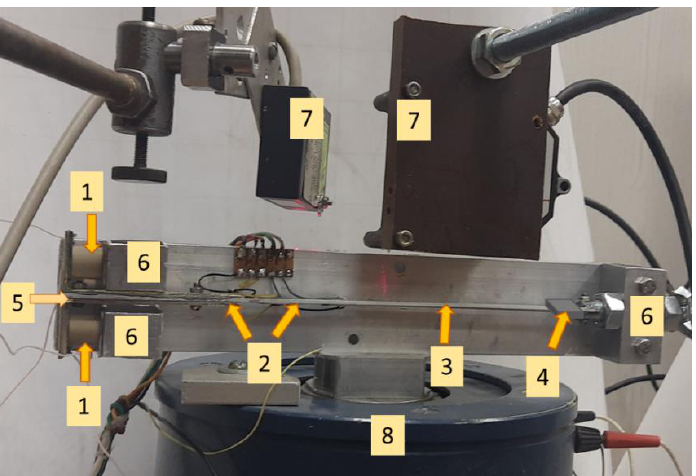
Figure 3. Experimental setup: (1) piezoelectric cylinders, (2) piezoelectric bimorphs, (3) duralumin substrate, (4) proof mass (5) L-shaped steel plate, (6) rigid punching, (7) optical linear displacement transducers, (8) electromagnetic vibrator.